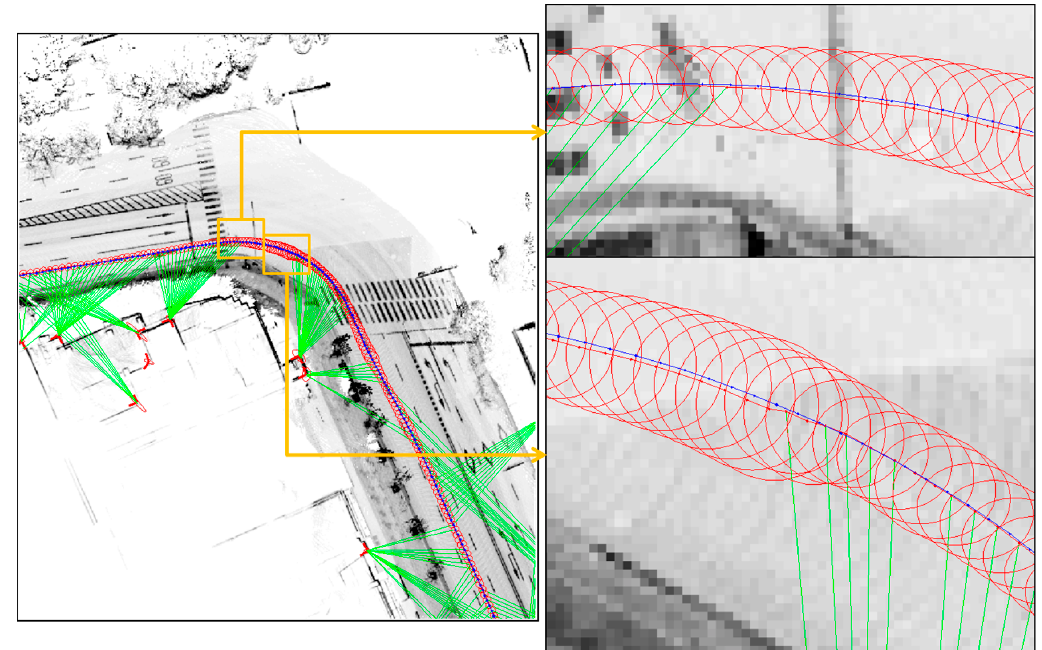
Figure 23. Vehicle trajectory with the position error covariance (the blue trajectory is the ground truth; the red trajectory is the estimated trajectory; the red ellipses represent the vehicle position error covariance; the green lines are to connect between the extracted corners and the vehicle position).